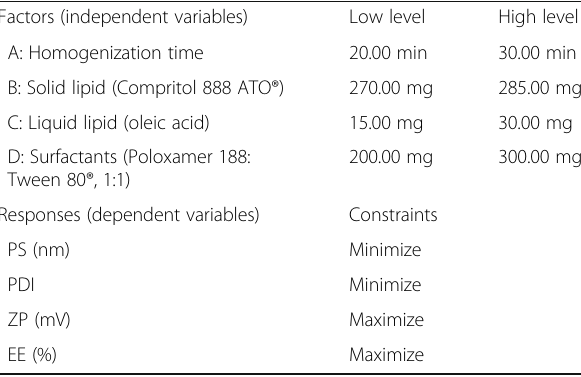
Table 1 Description of 2 4 full factorial design Factors (independent